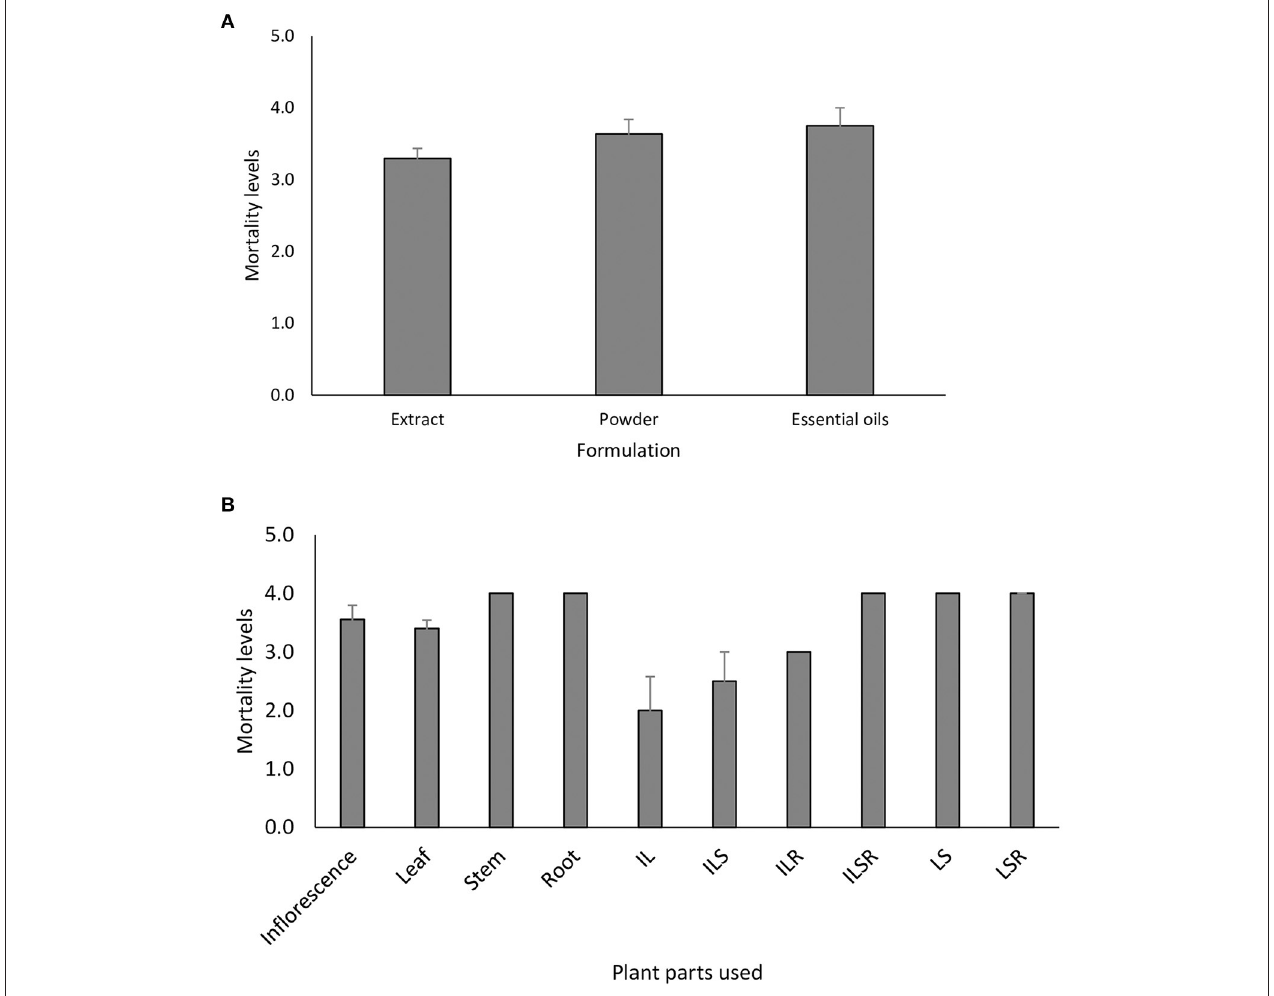
FIGURE 3 | Mean mortality rank ( ± se) of insect pests of agriculture and medical importance caused by (A) different formulations from, and (B) different plant parts or combinations plant parts of invasive alien plants. Data was obtained from 69 published case studies. IL, Inflorescence and leaf; ILS, Inflorescence, leaf and stem; ILR, Inflorescence, leaf and root; ILSR, Inflorescence, leaf, stem and root; LS, Leaf and stem; LSR, Leaf, stem,